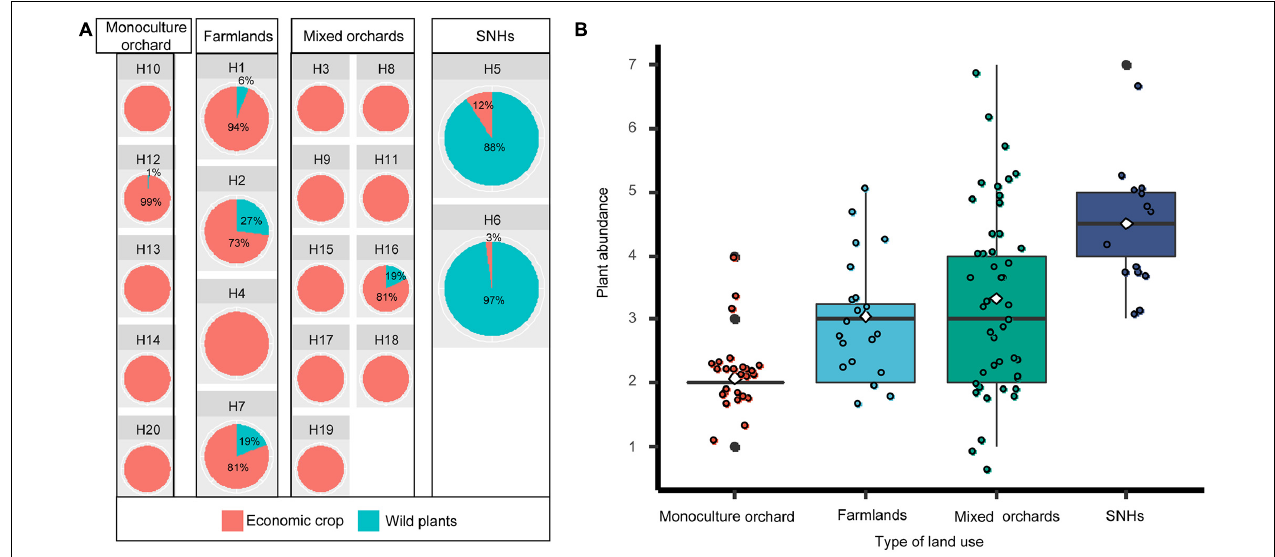
FIGURE 2 | The composition (A) and abundance (B) of beebread in different types of land use. (A) The proportion of economic crops and wild plants in each experimental plot. (B) Plant abundance under different land-use types. The X -axis and Y -axis represent land-use types and plant abundance, respectively.